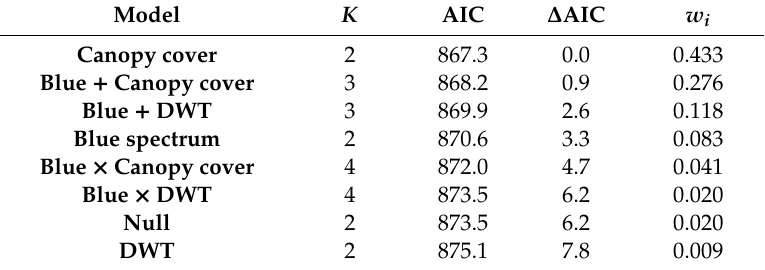
Table 3. Ranking of model support for a series of models predicting ground lichen biomass (g / m 2 ) in jack pine stands based on remotely sensed data using Akaike’s information criterion (AIC). Model name, parameter number, change in AIC, and Akaike weights are provided. Blue + canopy cover was chosen as the model of best fit. Band 3 is derived from satellite imagery (KOMPSAT), while canopy cover is derived from Airborne laser scanning (ALS) first returns above 1.37 m. DWT refers to the depth to water table.